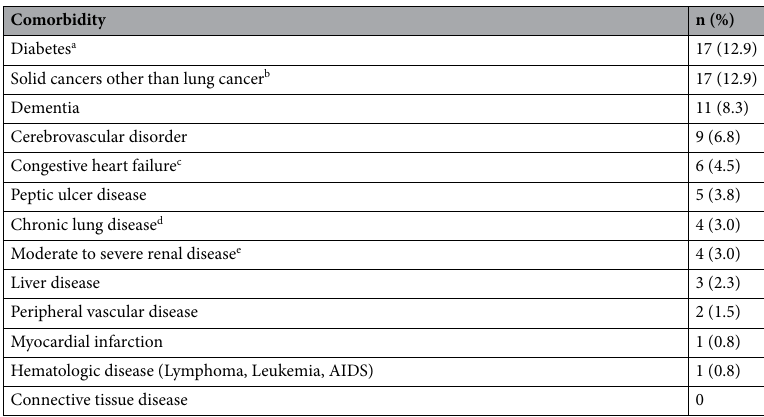
Table 2. The comorbidities at baseline based on the Charlson comorbidity index (n = 132). a Excluding patients treated without medication. b Diagnosed within the past 5 years. Solid cancers that do not require treatment at the time of enrollment, or where lung cancer is believed to determine the prognosis. c Exertional or paroxysmal nocturnal dyspnea and has responded to medications. d Leading to dyspnea even with mild exertion. e Severe = on dialysis, status post kidney transplant, uremia, moderate = creatinine > 3 md/dL.